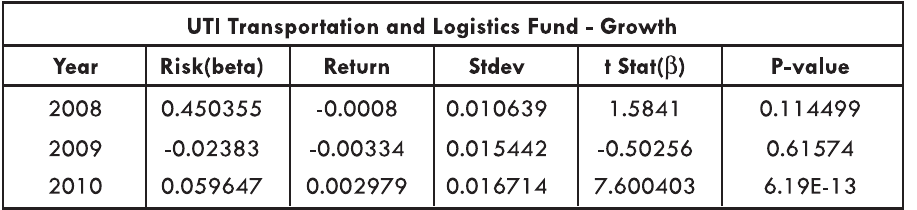
Table 10 : Risk and Returns of UTI Transportation and Logistics Fund - Growth Scheme during the Study Period (2008 to